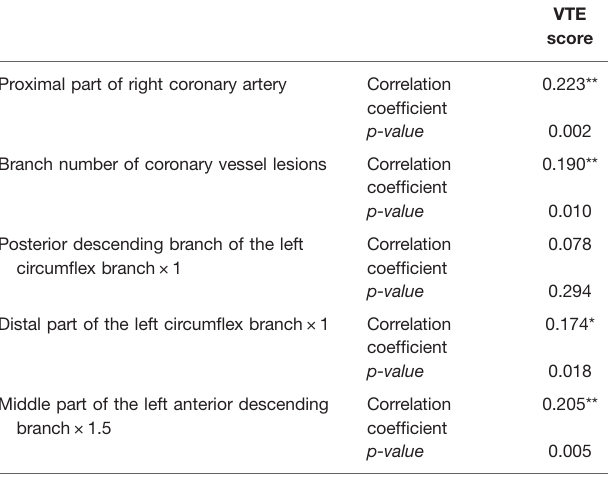
TABLE 7 | Pearson correlation coef fi cient of VTE scores and the proximal part of right coronary artery, the branch number of coronary vessel lesions, posterior descending branch of the left circum fl ex branch×1, distal part of the left circum fl ex branch×1, and the middle part of the left anterior descending branch×1.5